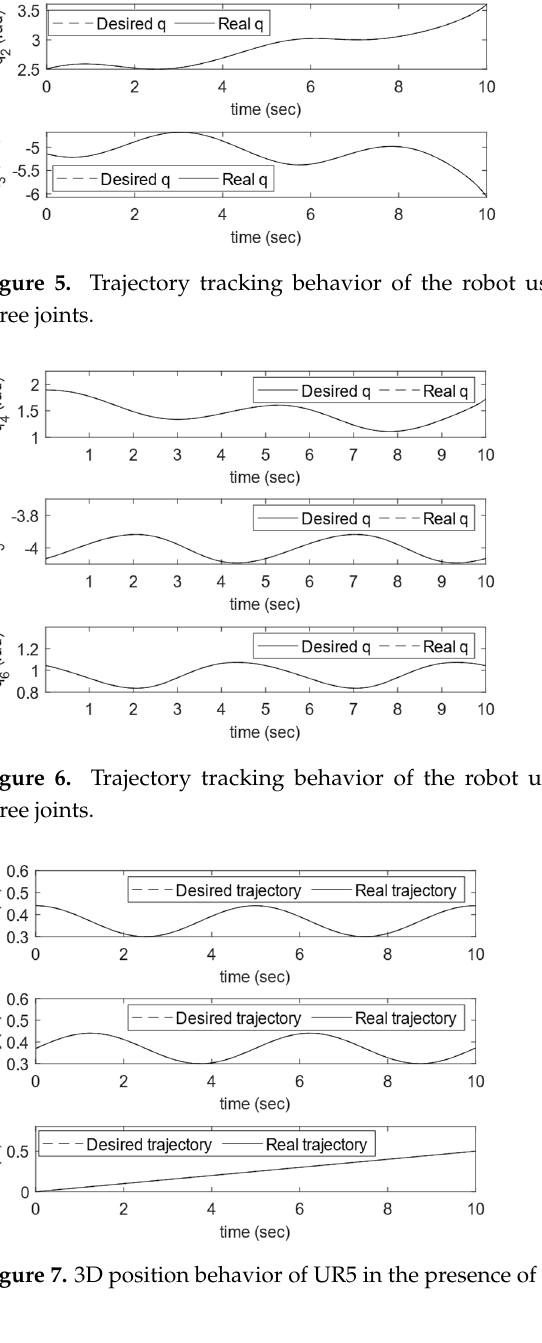
Figure 8. 3D orientation behavior of UR5 in the presence of the proposed controller. Figure 9 demonstrates the trajectory tracking behavior of UR5 in the xy- plane. For a better comparison between the real trajectory of the robot and its desired values, a